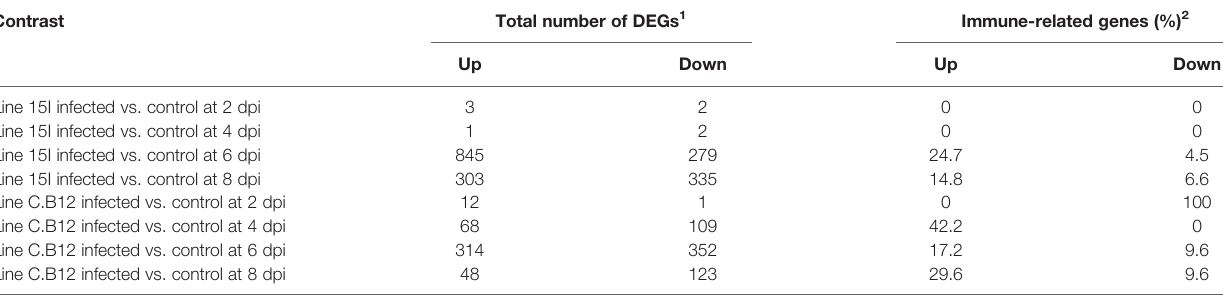
TABLE 3 | Number of differentially expressed genes (DEGs).